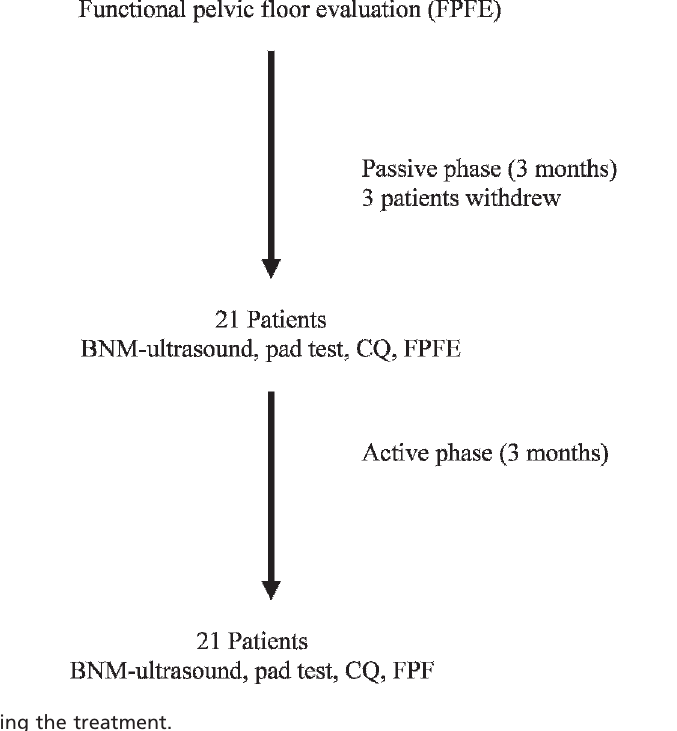
Figure 2 - Overview of patients during